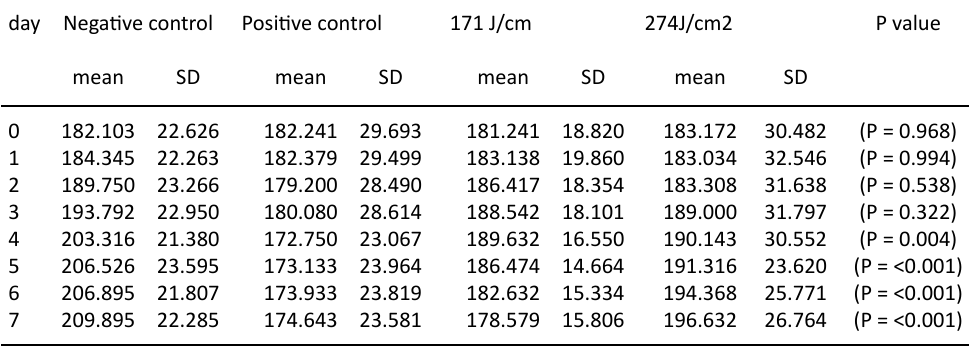
Table 3. Comparison of weight changes in day four Comparison